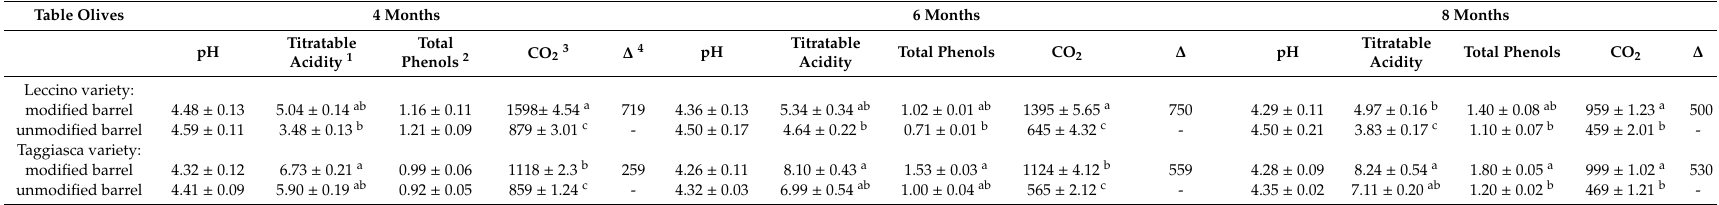
Table 4. Chemical analysis of brines from Leccino and Taggiasca black olives processed in two di ff erent types of industrial barrels. Table Olives